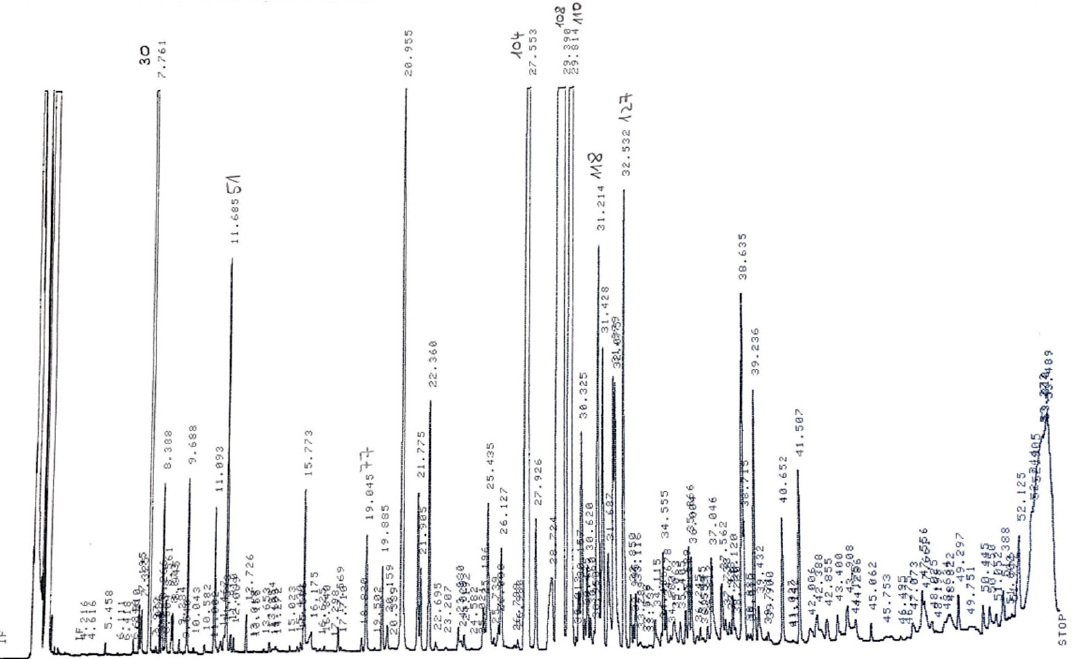
Figure 3. GC analysis chromatogram of Aurora variety HEOs obtained with propane as solvent at 40 °C and 50 bar. (Peak values: 30—myrcene, 51—linalool, 77—geraniol, 104— β -caryophyllene, 108— α -humulene, 110—farnesene, 118— α -selinene, 127— δ -cadinene.)